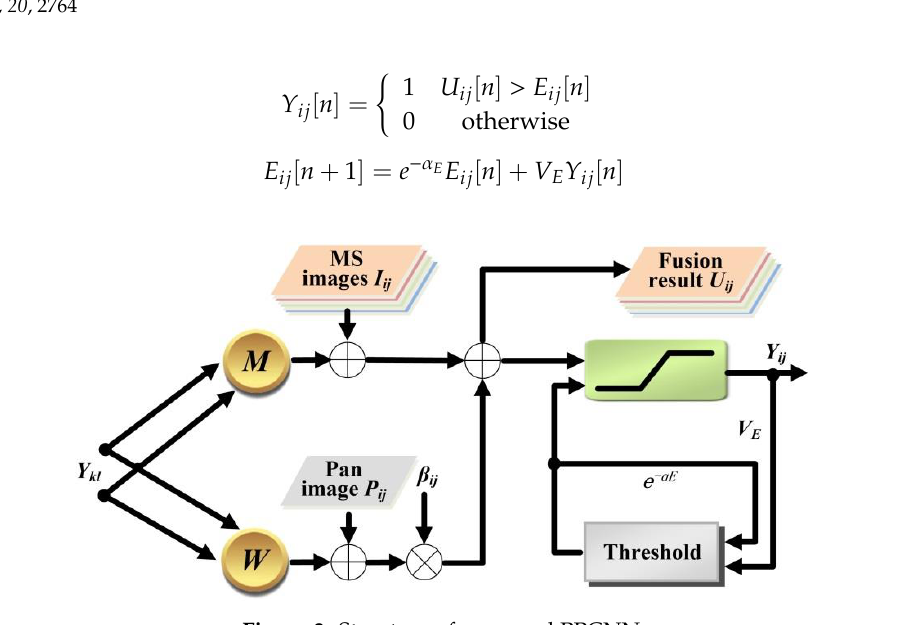
Figure 3. Structure of proposed PPCNN.